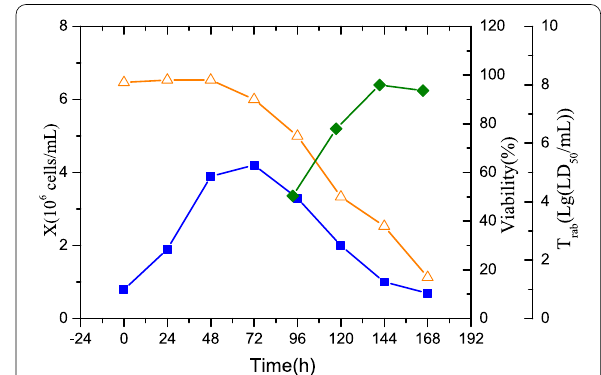
Fig. 7 Viable cell density ( X , filled square), viability (triangle), and virus titer ( T rab , filled diamond) in the batch culture of BHK-21 cells in the 1000-L